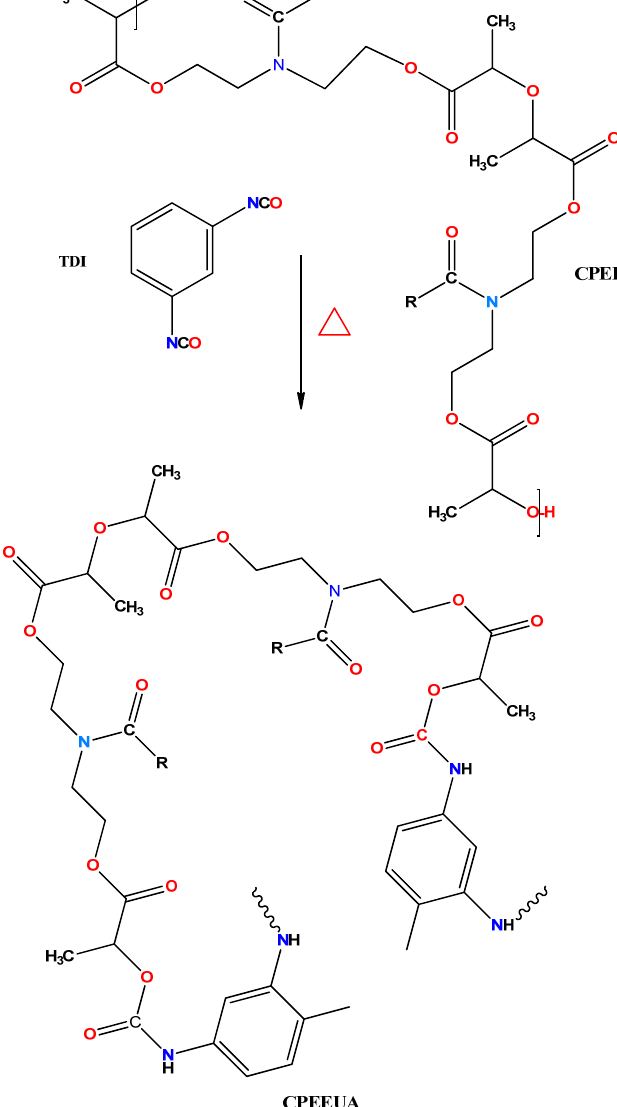
Scheme 2. Synthesis of Canola oil poly (ester–ether–amide–urethane) (CPEEUA).